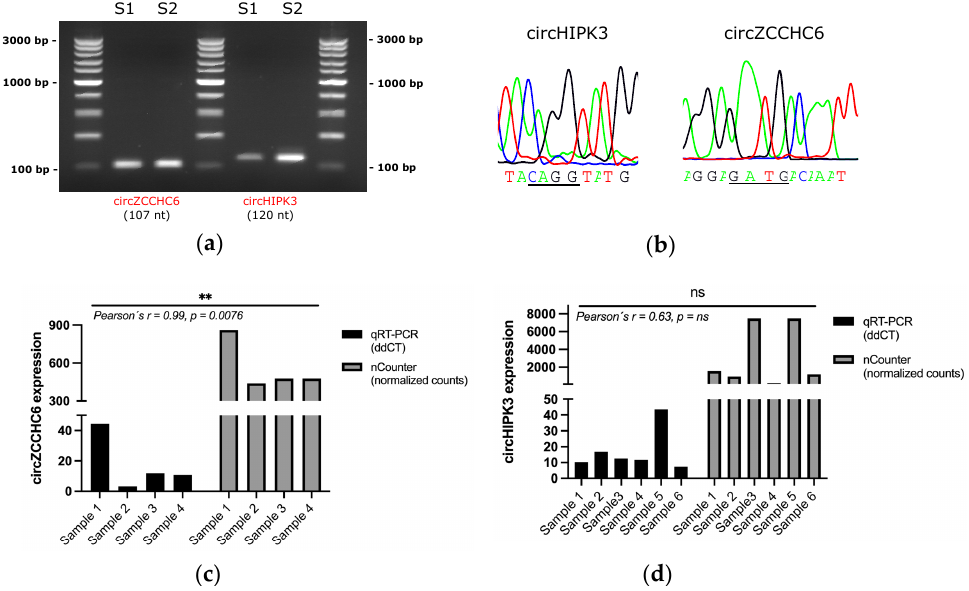
Figure 6. Validation of nCounter results by RT-qPCR and further Sanger sequencing. ( a ) Electrophoresis gel of amplified circZCCHC6 (107 nt) and circHIPK3 (120 nt); ( b ) Sanger sequencing results spanning the junction site (underlined) of cited circRNAs; Comparison of nCounter normalized counts versus ∆∆ Cts values by RT-qPCR for circZCCHC6 ( c ) and circHIPK3 ( d ) in analyzed samples. Pearson’s correlation coefficient is indicated. NS, not significant. ** means two grades of significant (p < 0.01).